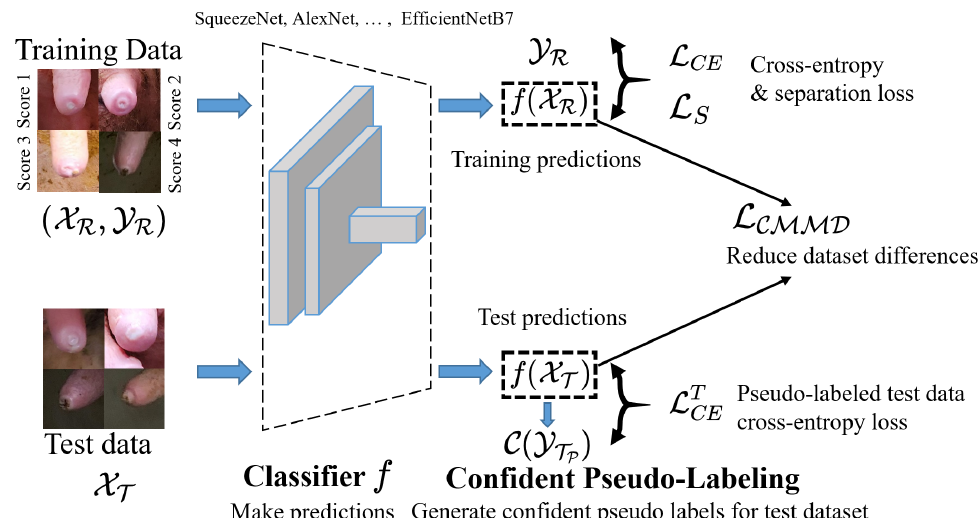
Figure 2. The learning scheme of our proposed SCTL model. We first fine-tune the classifier f from seventeen well-known ImageNet models and then make predictions for the training ( X R ) and test datasets ( X T ). For the training data, we minimize the typical cross-entropy loss ( L CE ) and the separation loss ( L S ) to improve the inter-class dispersion. For the test data, we generate confident ) } ) in the t adjustment learning, and then we minimize the pseudo labeled examples ( {C ( X T t ) , C ( Y T t P pseudo labeled test data cross-entropy loss ( L T ). To reduce the dataset differences, we also develop CE a categorical maximum mean discrepancy loss L CMMD to improve intra-class